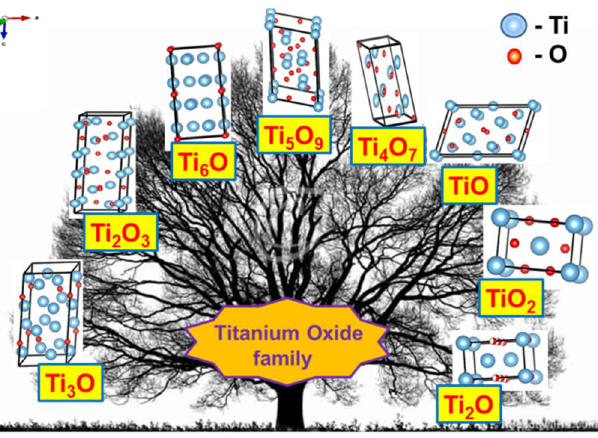
Figure 6. Crystal structures of various titanium oxides.